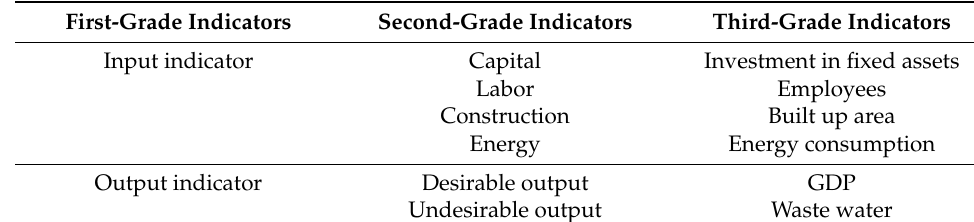
Table 3. Measurement of input and output indicators by urban ecological efficiency.